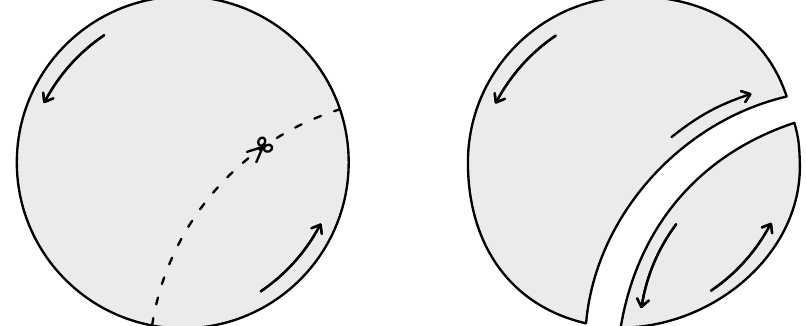
Figure 1: We cut the bulk spatial slice open along the RT surface and factorise the bulk Hilbert space explicitly. The edge modes now run both along the bulk cut and the boundary of AdS 3